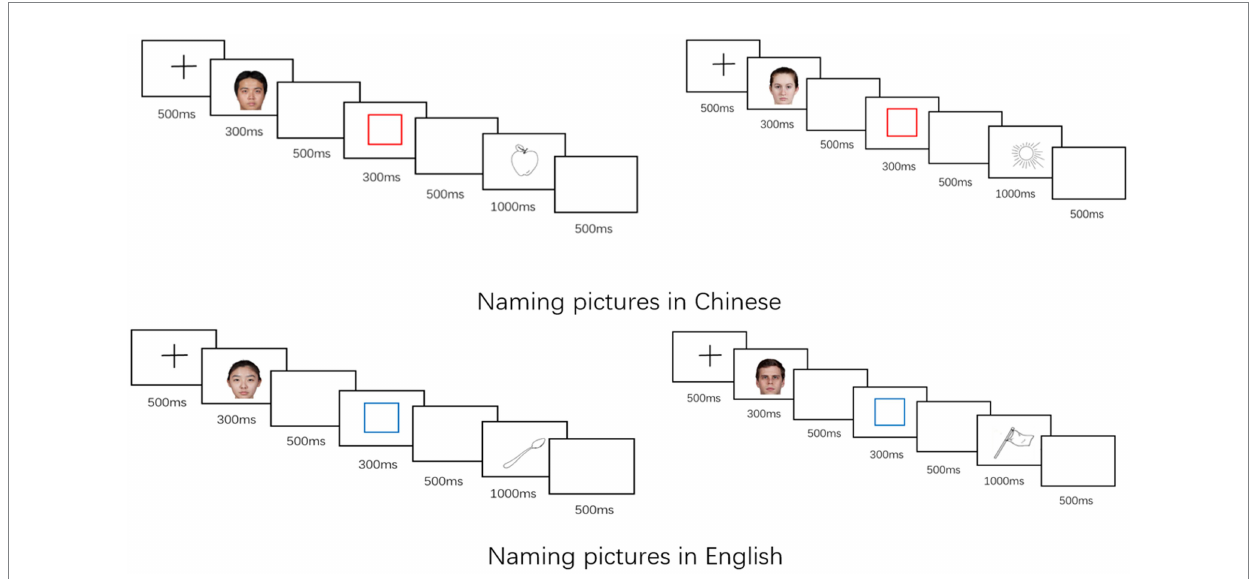
FIGURE 1 Task paradigm of mixed-language picture naming in the two face-language matched sessions (25% face-language matched session and 75% face- language matched session). There were two congruent conditions (speaking Chinese after viewing an Asian face; speaking English after viewing a Caucasian face) and two incongruent conditions (speaking Chinese after viewing a Caucasian face; speaking English after viewing an Asian face). In the 25% face-language matched session, the ratio of the congruent versus incongruent trials was 25%, while in the 75% face-language matched session, the ratio was